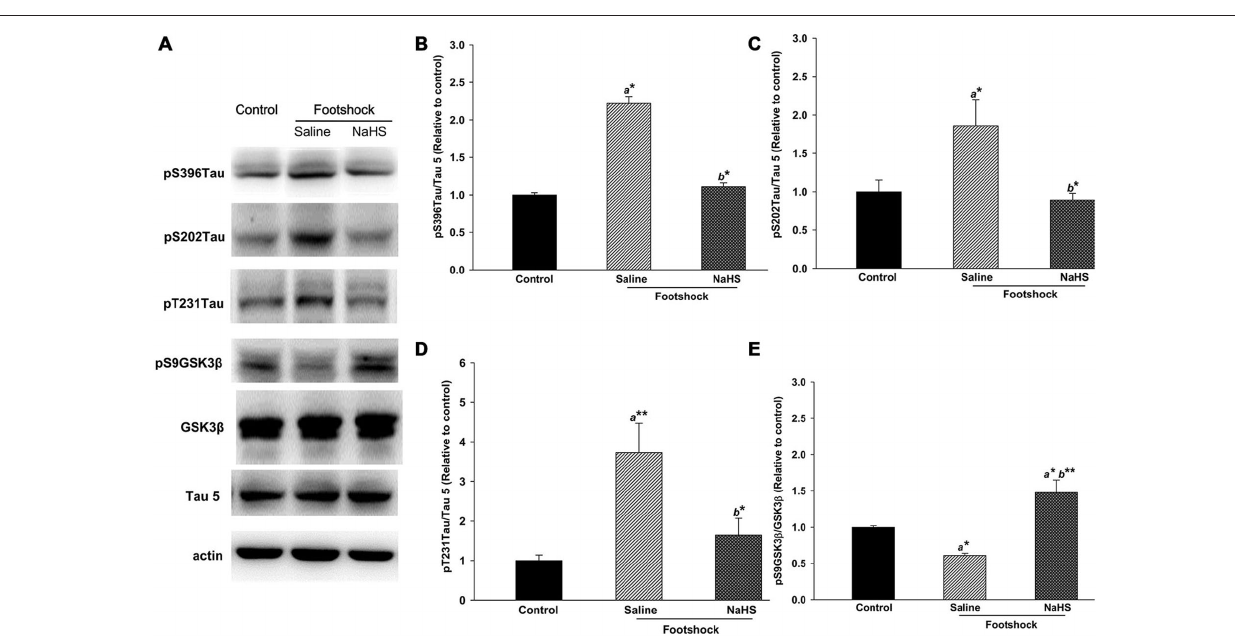
Frontiers in Behavioral Neuroscience | www.frontiersin.org